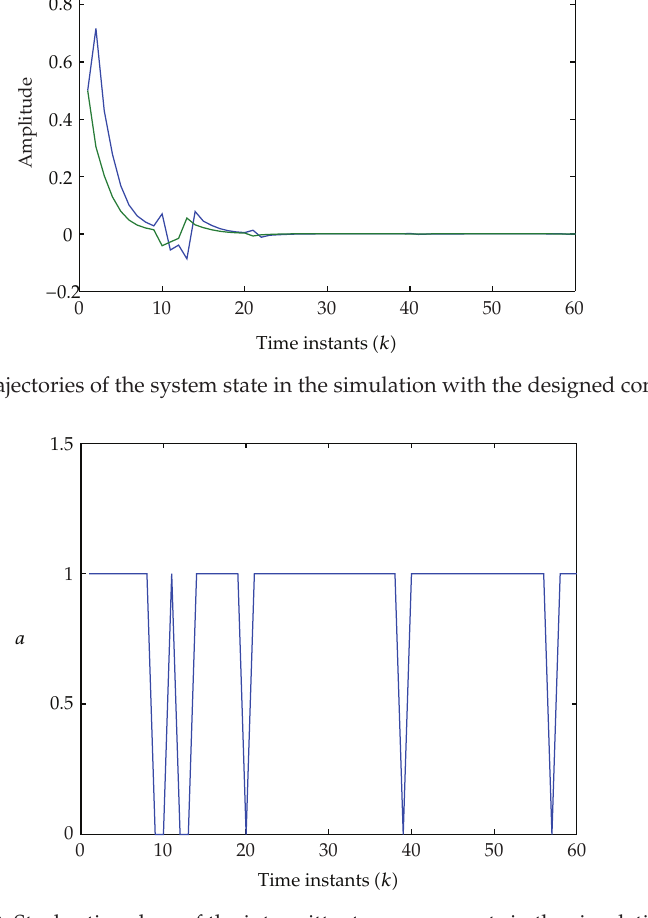
Figure 3: Stochastic values of the intermittent measurements in the